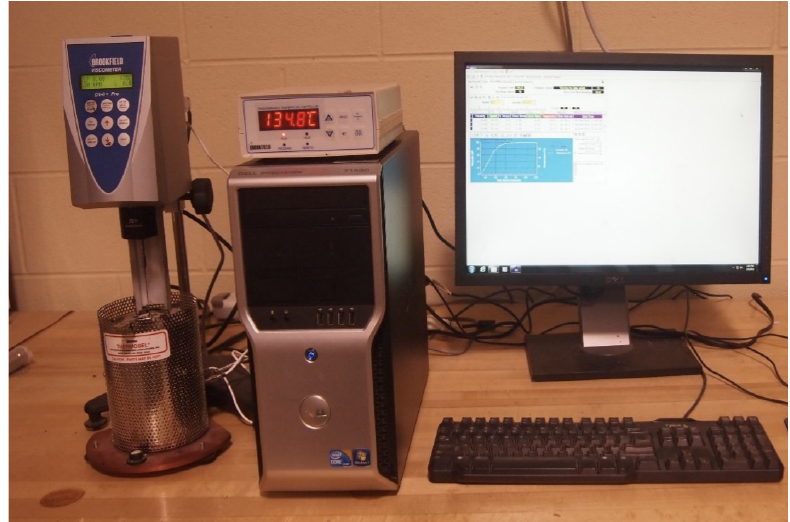
Figure 5. The rotational viscometer.